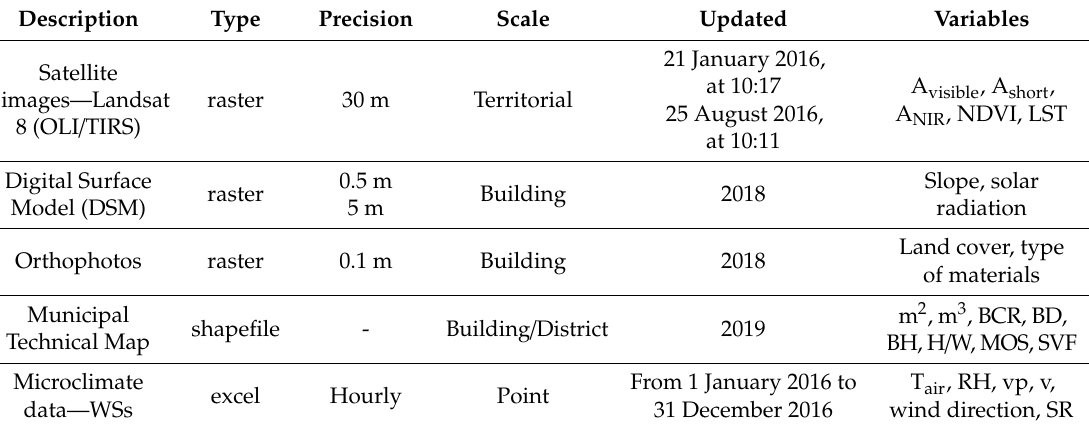
Table 2. Description of the data and their collection